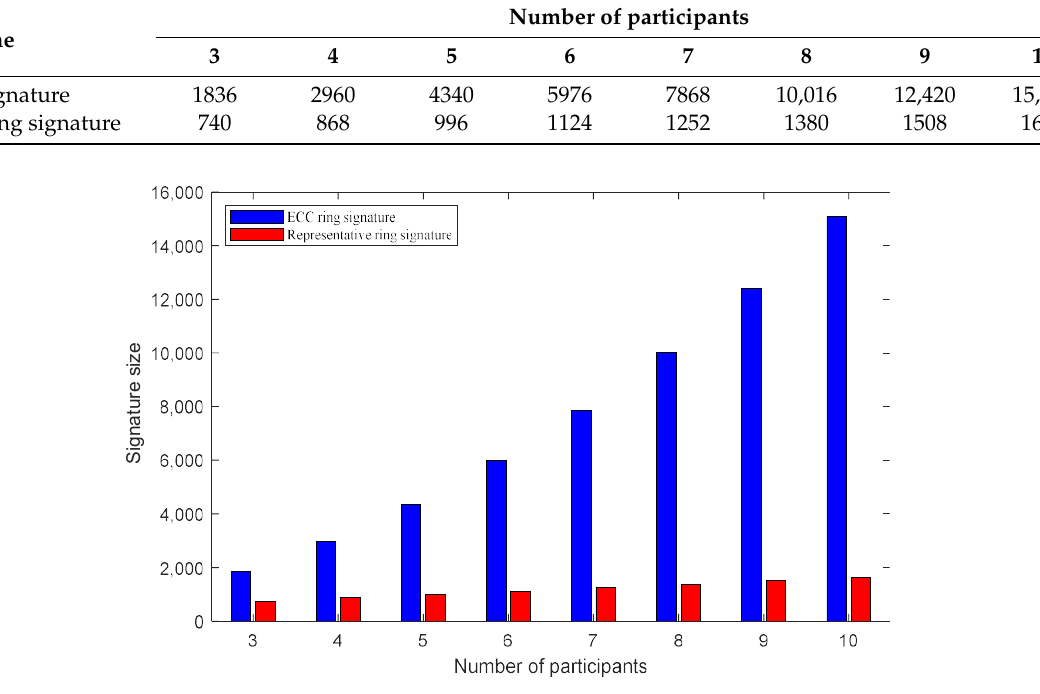
Figure 6. The comparison of signature sizes.